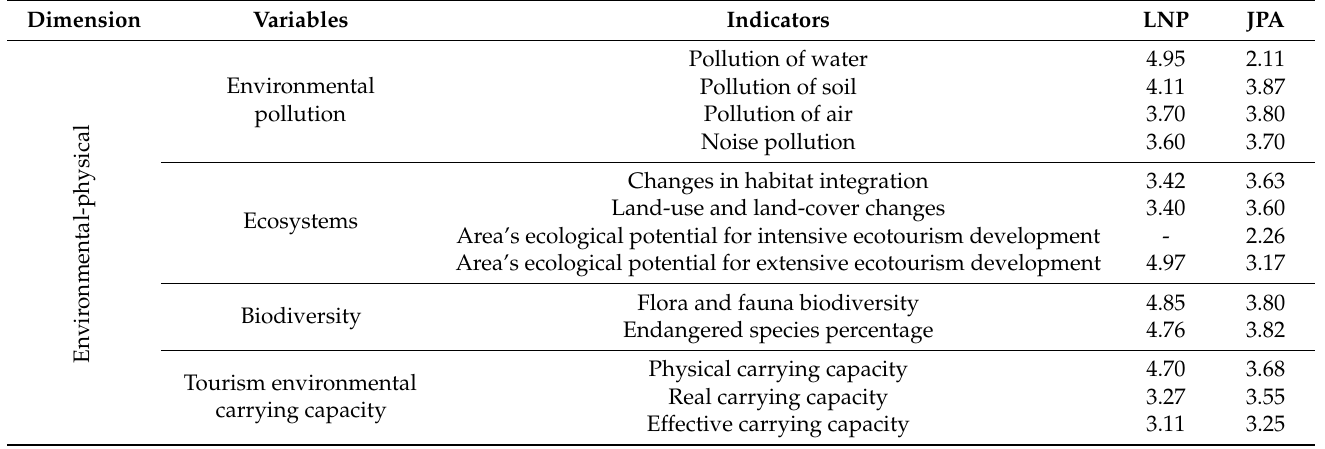
Table 1. Evaluation of the (mean) sustainability level of ecotourism development in two protected areas (based on respondents’ self-assessment).